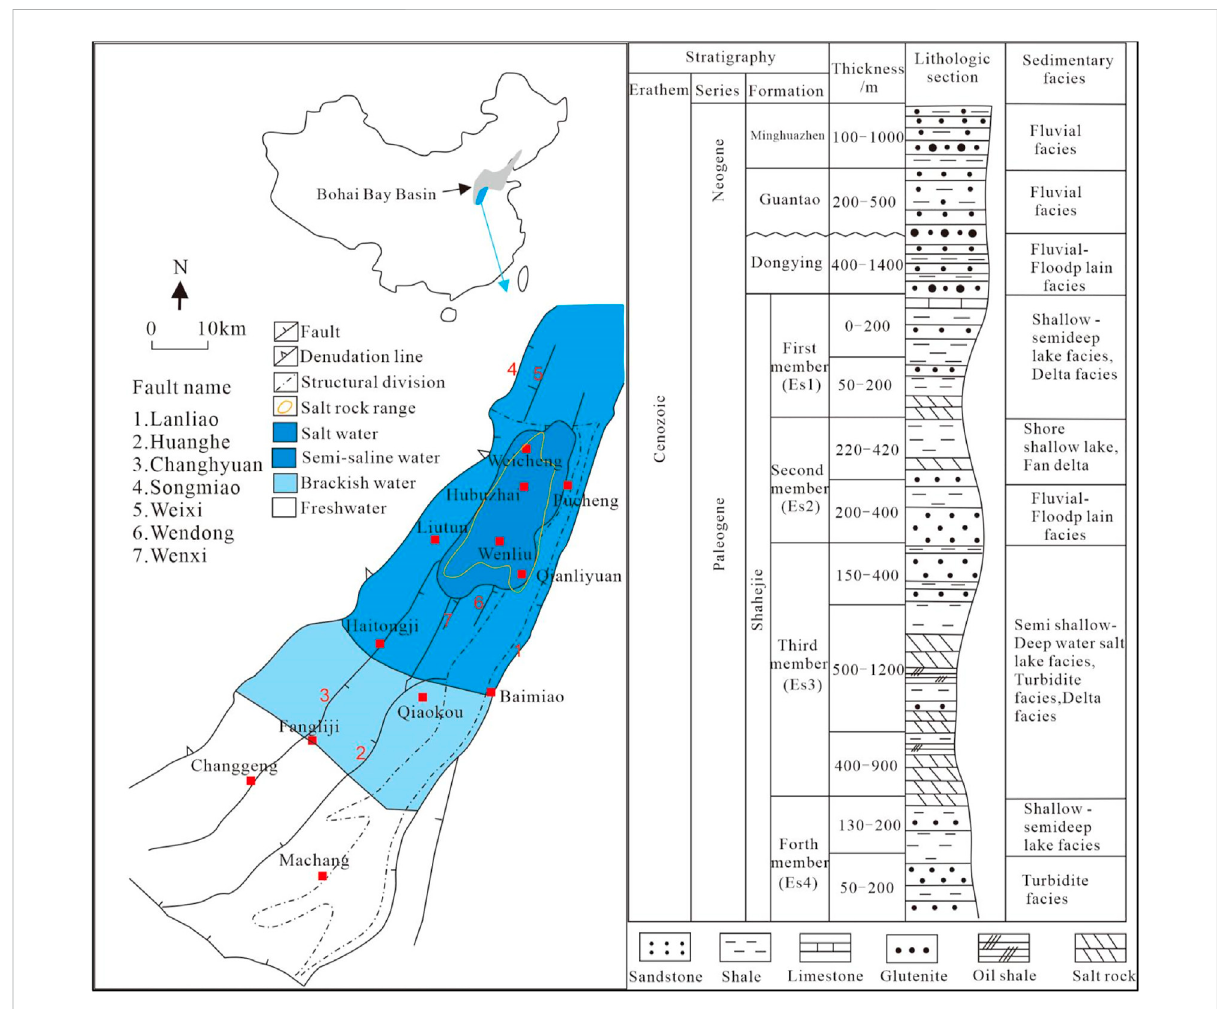
FIGURE 1 Geological characteristics of shale development in the Northern Dongpu